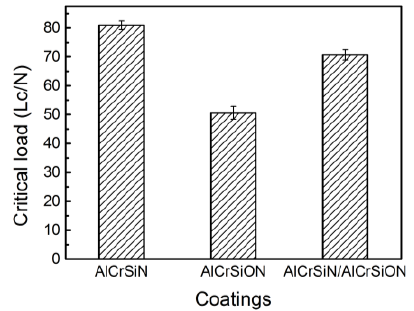
Figure 8. Critical loads of the AlCrSiN coating, AlCrSiON coating, and AlCrSiN/AlCrSiON duplex coating.